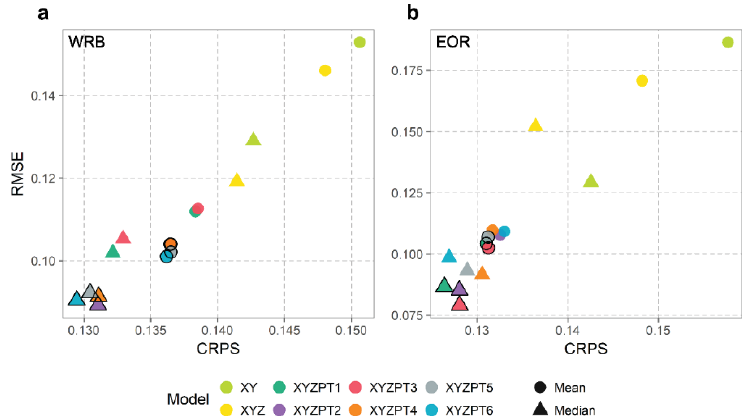
Figure 2. Comparison of mean and median continuous ranked probability score (CRPS) and root mean squared error (RMSE) for ( a ) the WRB region and ( b ) the EOR region. The top performing three or four models are closely clustered where one may perform better with respect to CRPS, while another may have a slightly better RMSE. The top performing models across both mean and median results in ( a ) are XYZPT2, XYZPT4, XYZPT5, and XYZPT6, while the top performing in ( b ) are XYZPT1 and XYZPT3.